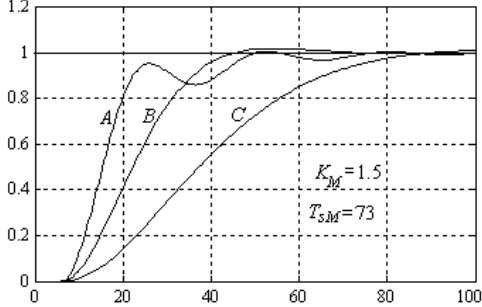
Figure 16. Closed-loop system responses y ( t ) to a unit step reference for: (A) τ M = 15, K = 7.5; (B) τ M = 8, K = 2.4; (C) τ M = 0, K =